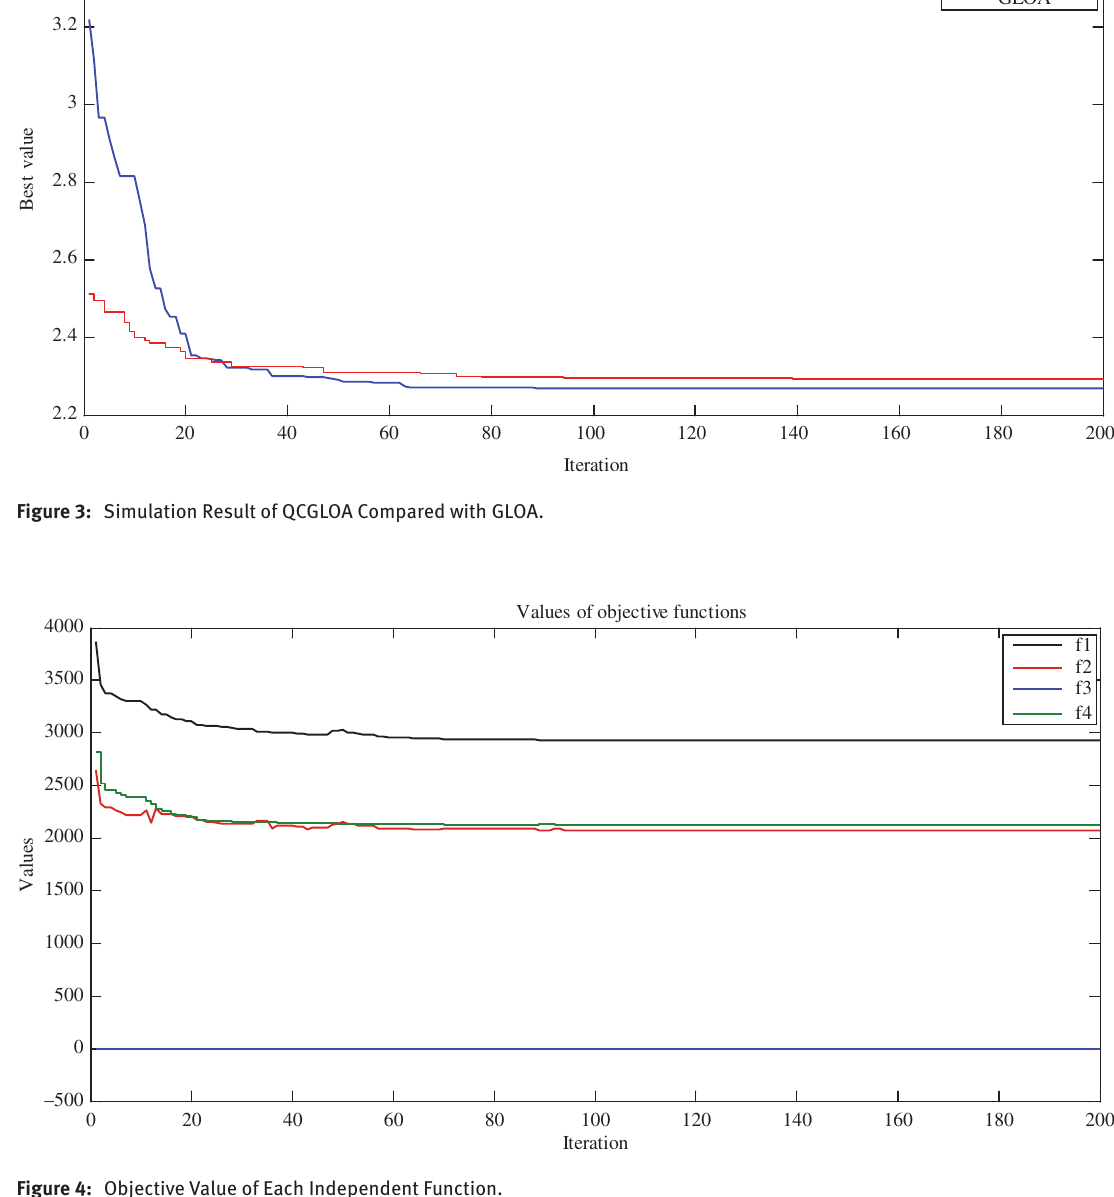
Figure 4: Objective Value of Each Independent